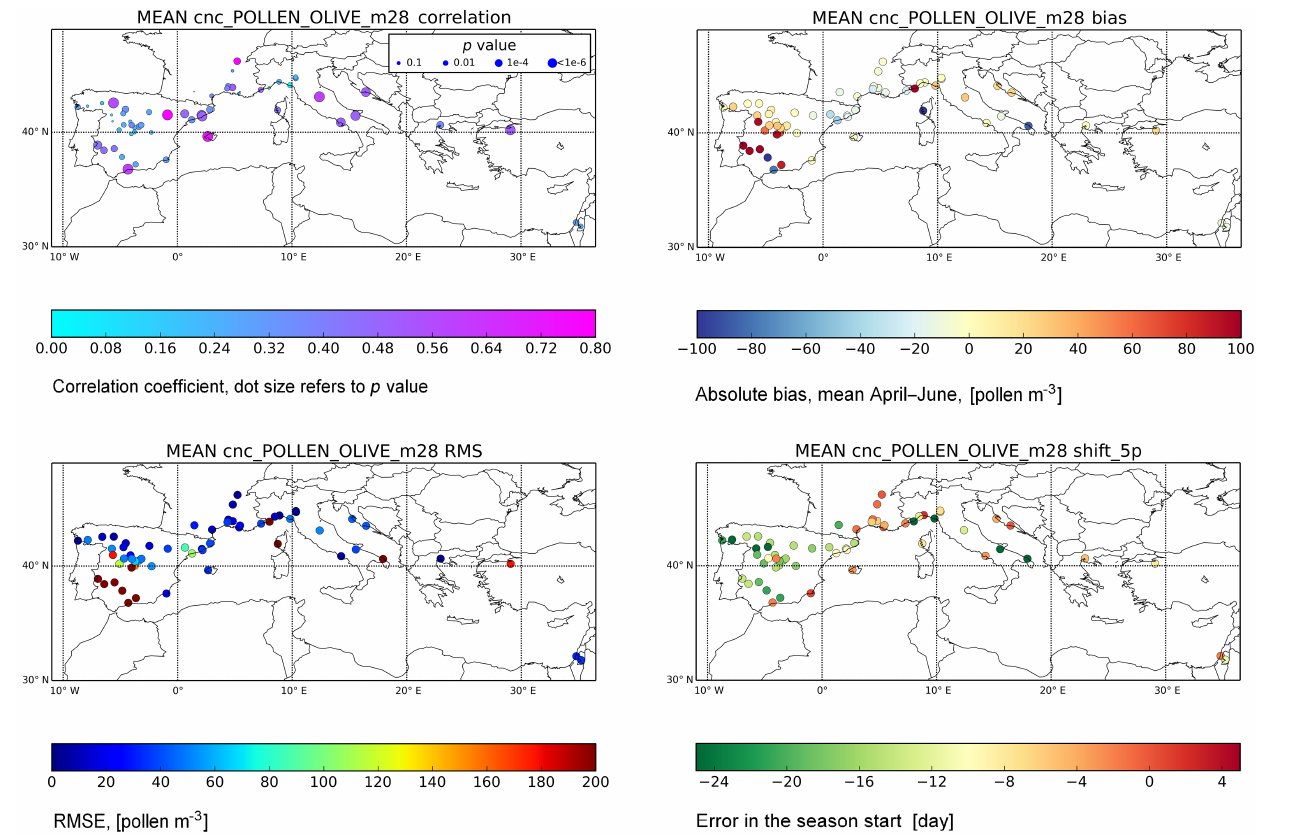
Figure 7. Results of model–measurement comparison for the ensemble mean: correlation coefficient for daily time series, mean bias April– June (pollenm − 3 ), RMSE (pollenm − 3 ), and error at the start of the season